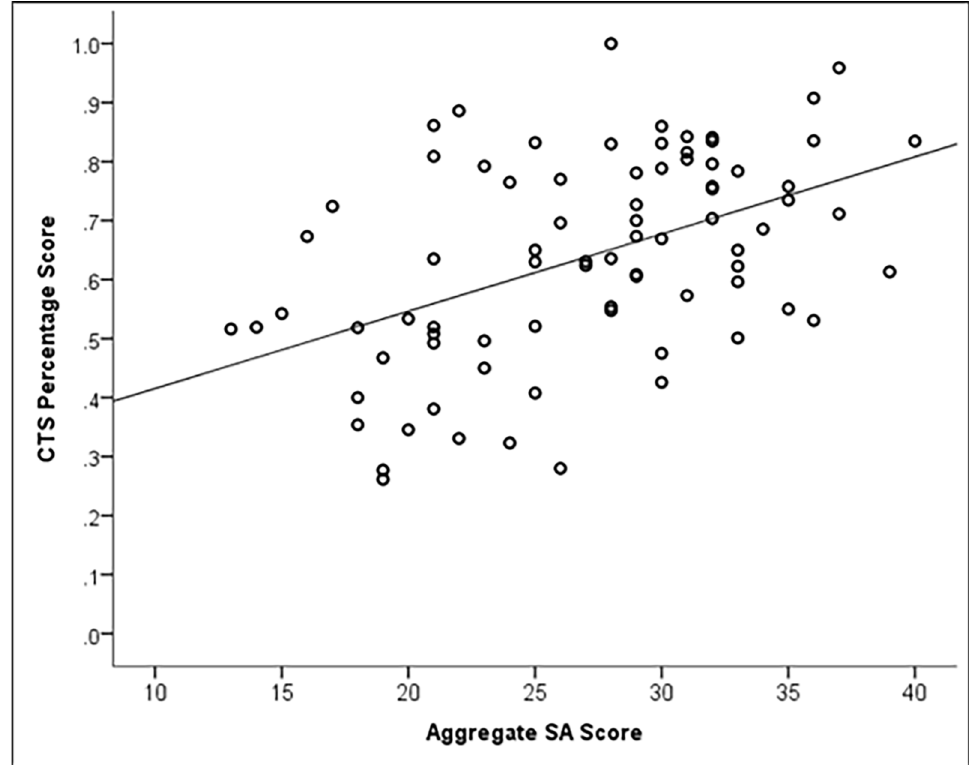
Fig 1. Scatterplot summarizing the relationship between SA and CTS percentage scores. The solid line represents the line of best fit. CTS = Clinical Teamwork Scale; SA = Situation Awareness.